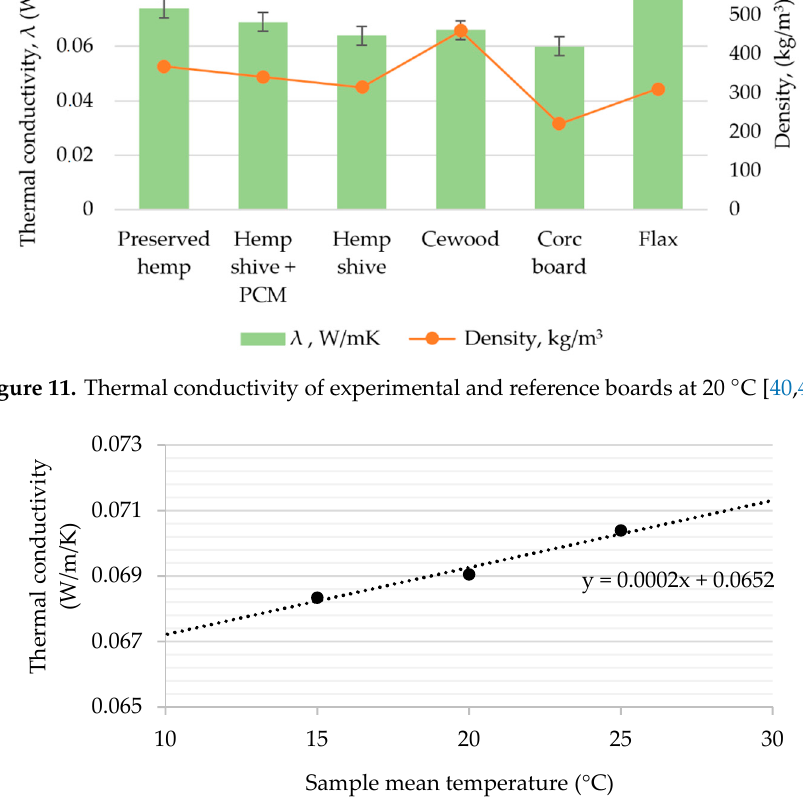
Figure 12. An example of thermal conductivity dependence on mean temperature (Hemp shive with PCM).